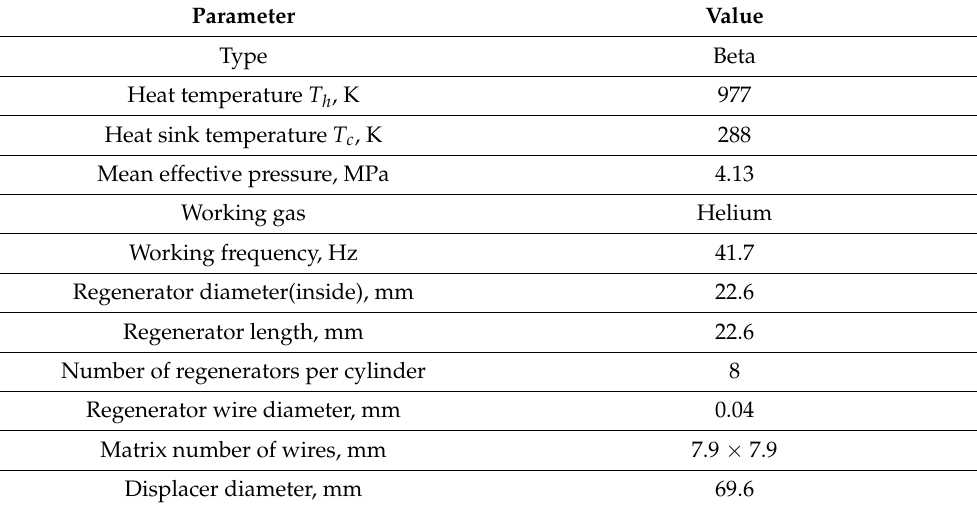
Table 1. GPU-3 engine design parameters.